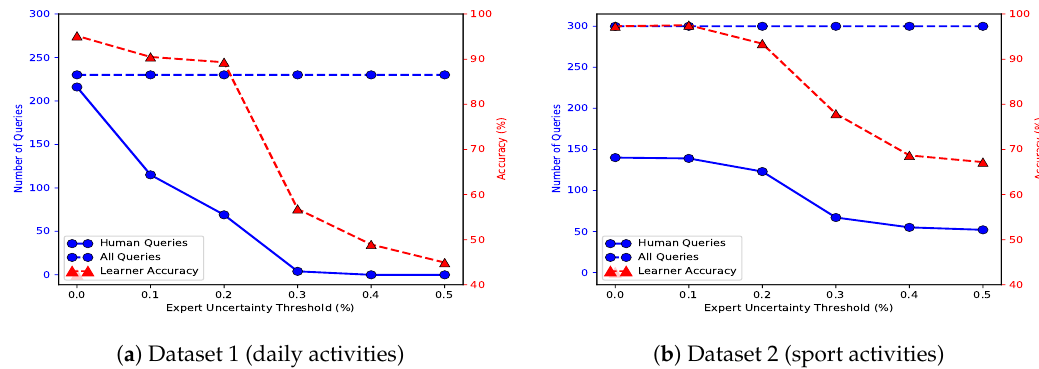
Figure 7. Expert uncertainty threshold versus activity recognition accuracy (right axis) and number of queries (left axis). Subfigure ( a ) shows results for the daily activities dataset, and subfigure ( b ) shows results for the sport activities